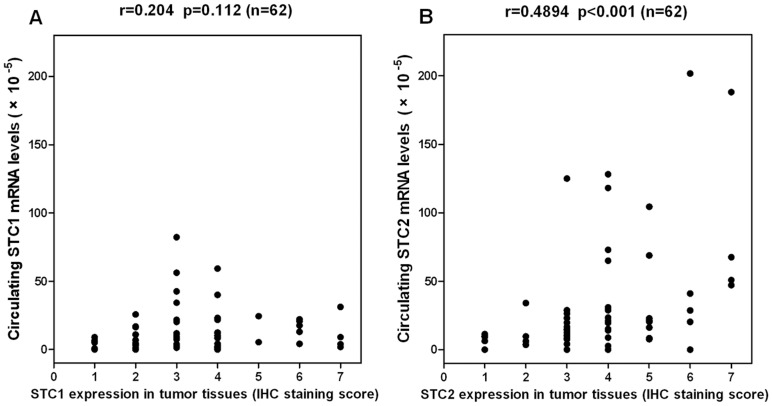
Correlations of circulating STC1 (A) or STC2 (B) mRNA with the corresponding protein in tumors.STC1 or STC2 protein expression was based on the immunohistochemical staining scores (1 to 7) of the LSCC samples. r, Spearman’s rank correlation coefficient.